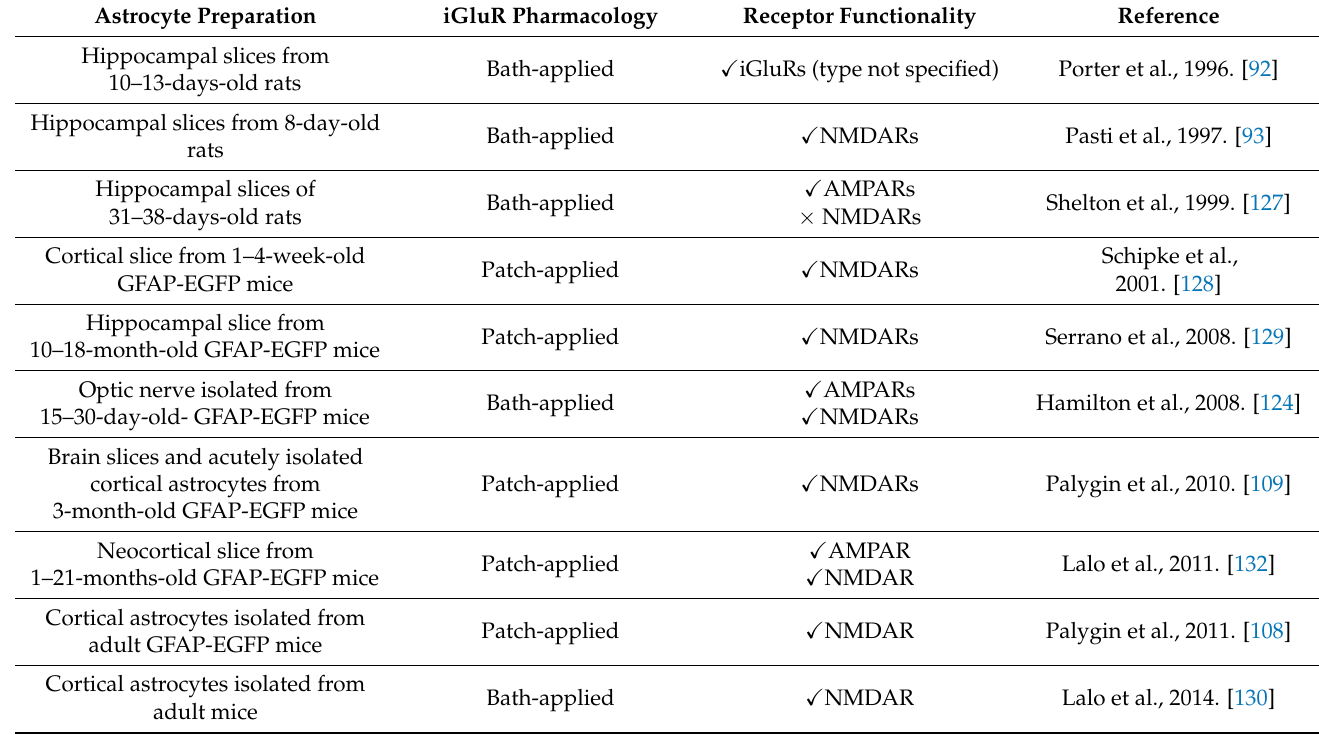
Table 2. Evidence of iGluR-mediated Ca 2+ activity from Ca 2+ imaging in ex vivo brain slices or acutely isolated astrocytes. Bath or pipette application of drugs are indicated, which affects cell-type specificity. (cid:88) and × show the presence or absence of function receptors in each